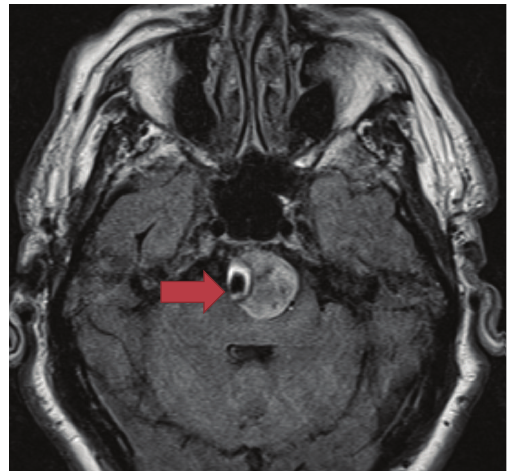
Figure 4: MRI Interpretation: Large partially thrombosed 25 mm basilar artery aneurysm without evidence of rupture. There is an acute or early subacute infarct within the left posterior inferior cerebellar artery distribution. There is also a questionable small focus of acute or early subacute infarct at the left posterolateral pon- tomedullary junction. There is no hydrocephalus or